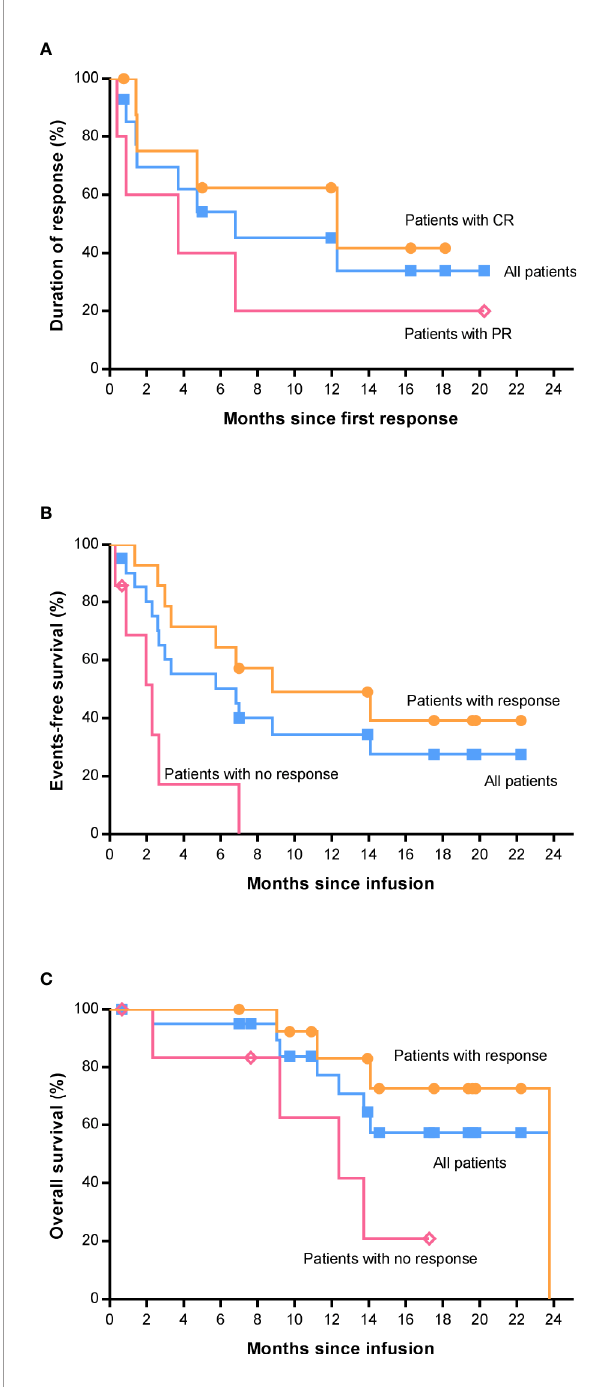
FIGURE 4 | Survival analysis of patients by the Kaplan-Meier method. (A) Duration of response among the 14 patients who had a response. (B) Event-free survival between patients with and without response. (C) Overall survival between patients with and without response. CR, complete response; PR, partial response; HSCT, hematopoietic stem cell transplantation.